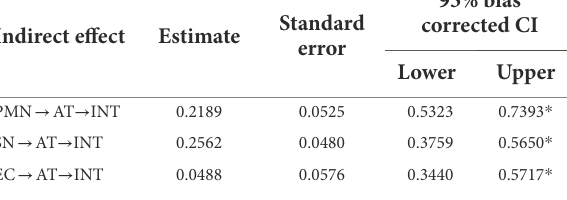
TABLE 5 The bootstrap results of the mediation.